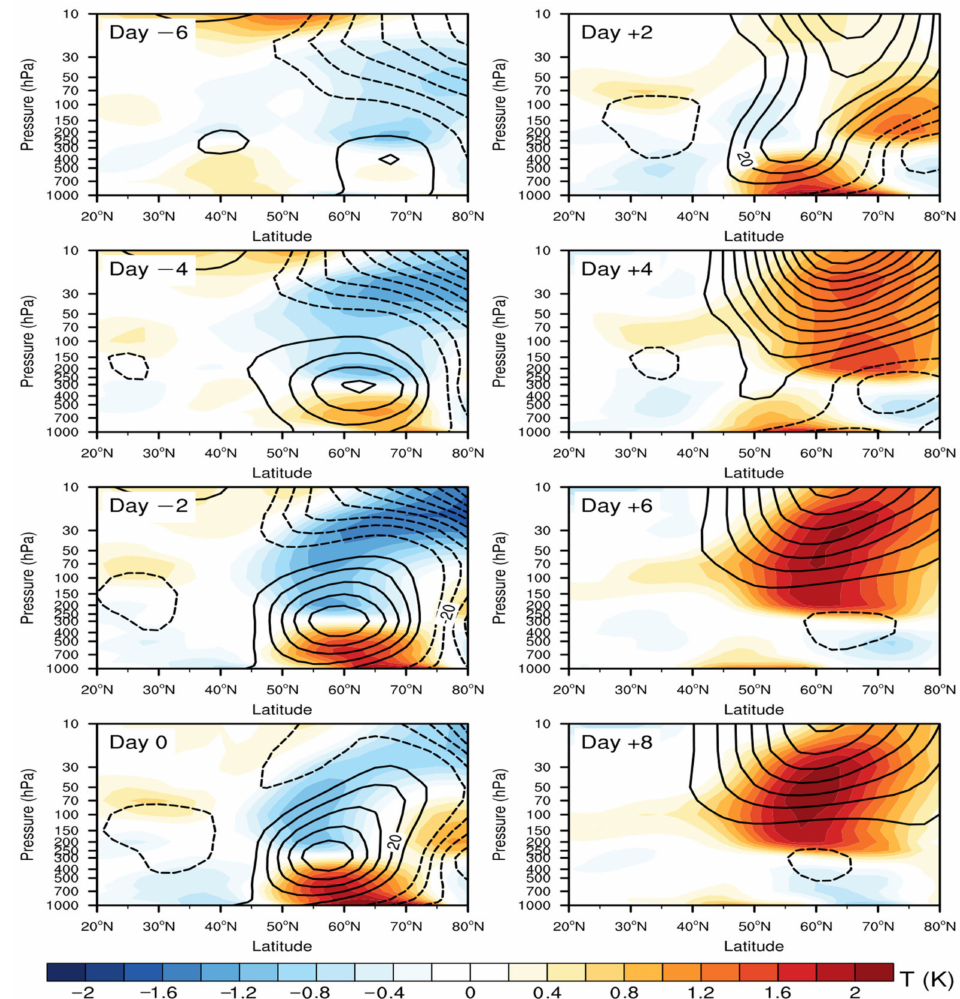
Figure 6. The regressed meridional–vertical distribution of the 10–60-day filtered geopotential height anomalies (contours; unit: gpm) and temperature anomalies (shadings; unit: K) on PC1 of 2018 wintertime over Eurasian region averaged from 20 ◦ to 140 ◦ E. Contour interval for the geopotential height anomalies is 10